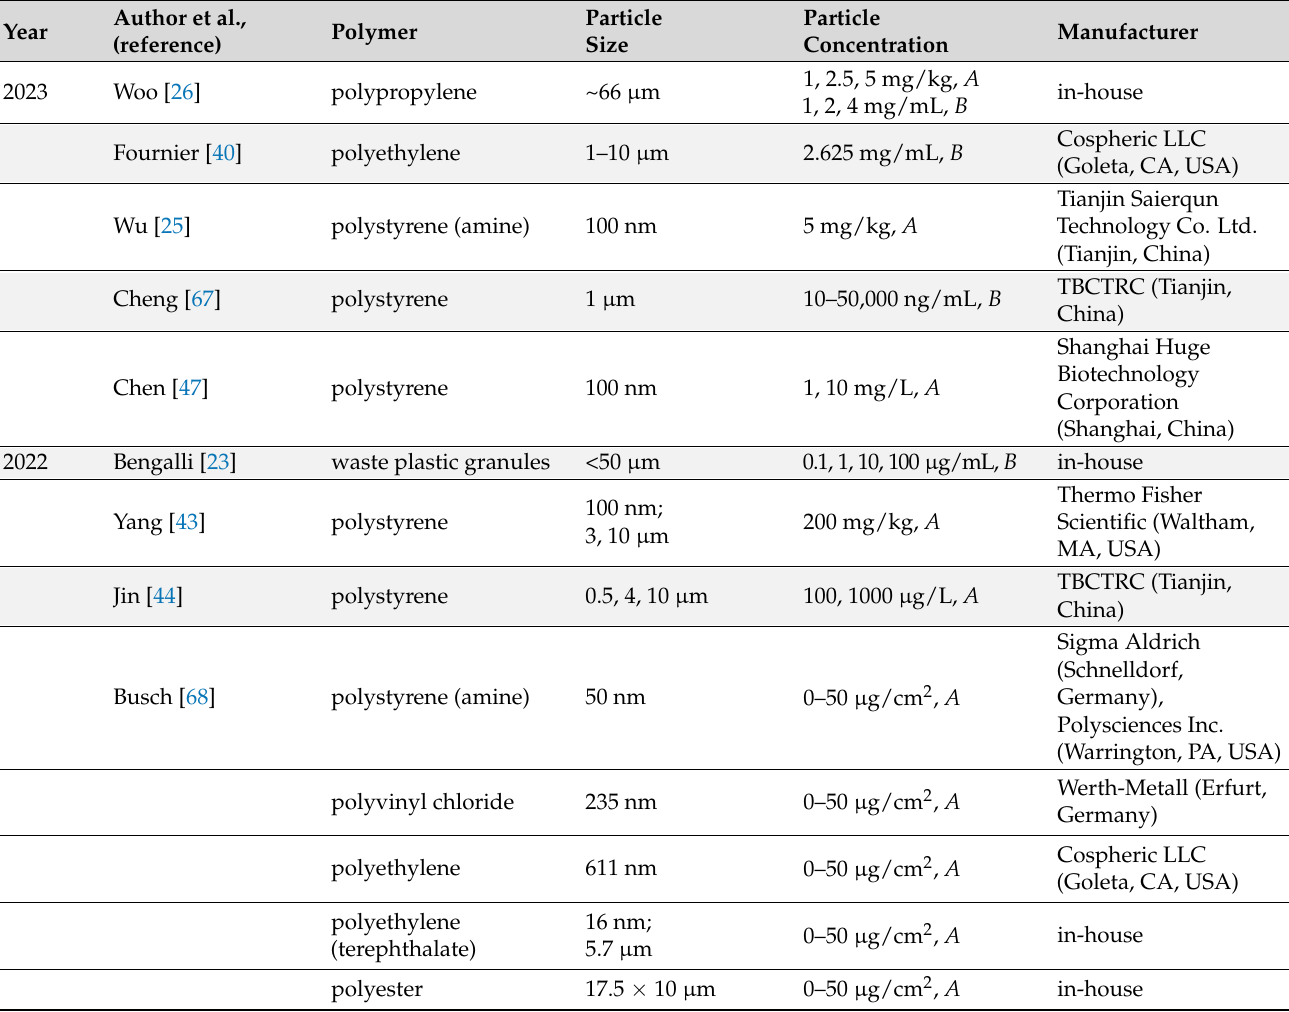
Table 1. Studies investigating the effects of micro- and nanoplastics on mammals (in vitro and in